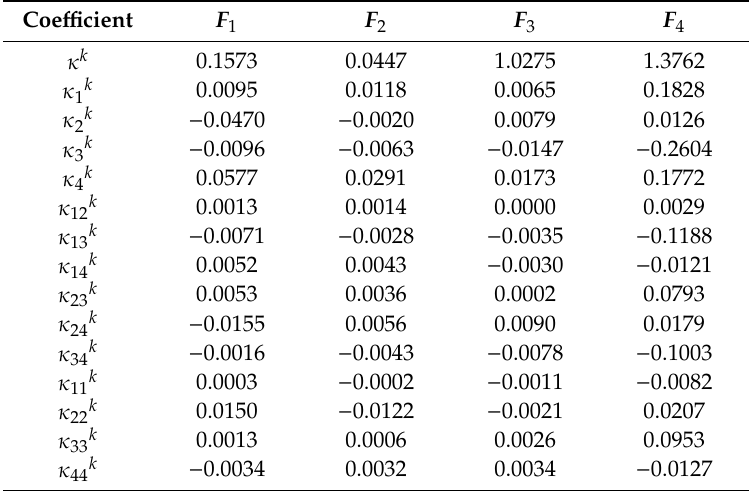
Table 3. Proxy coe ffi cients for the various objective functions